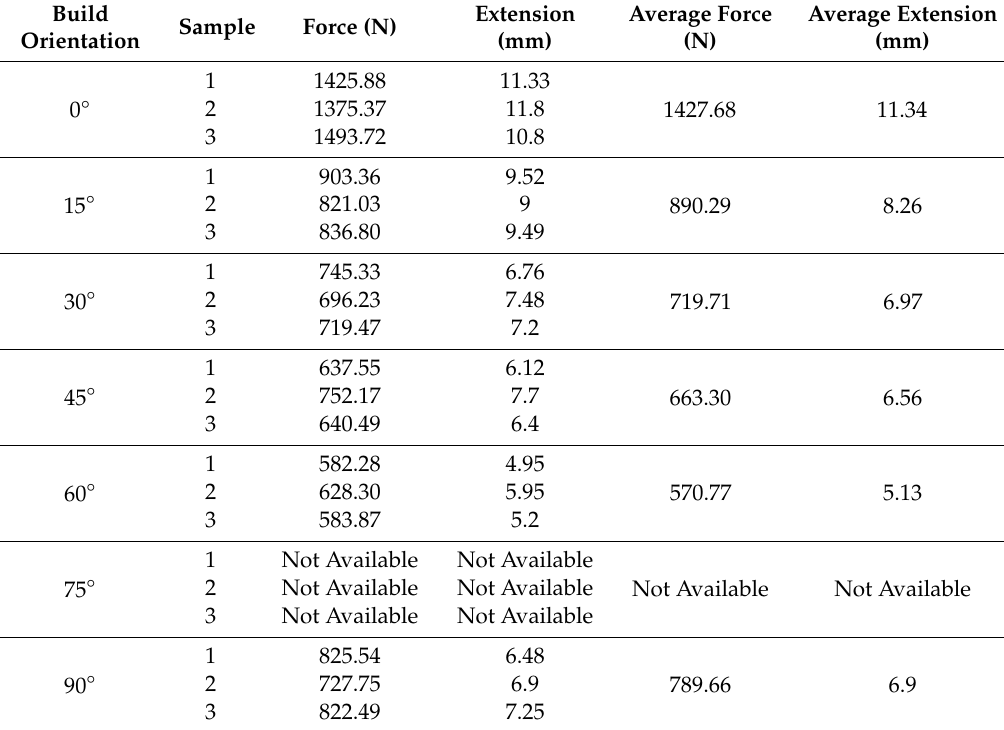
Figure 12. Failure in random specimens. Table 5. Maximum tensile load for flat